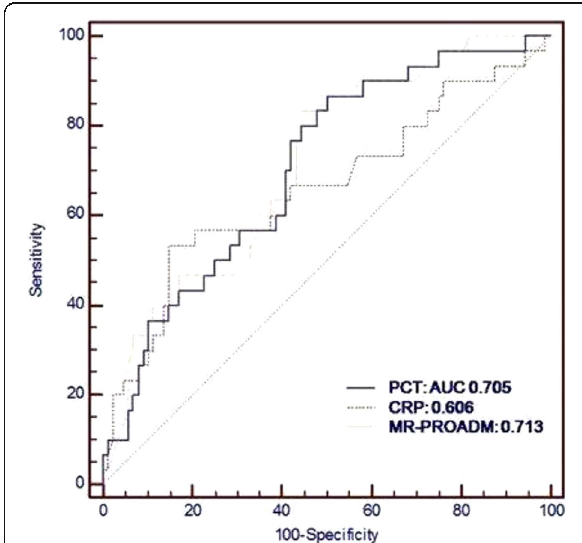
Fig. 1 (abstract 0124). Comparison of ROC curves of biomarkers to ICU admission